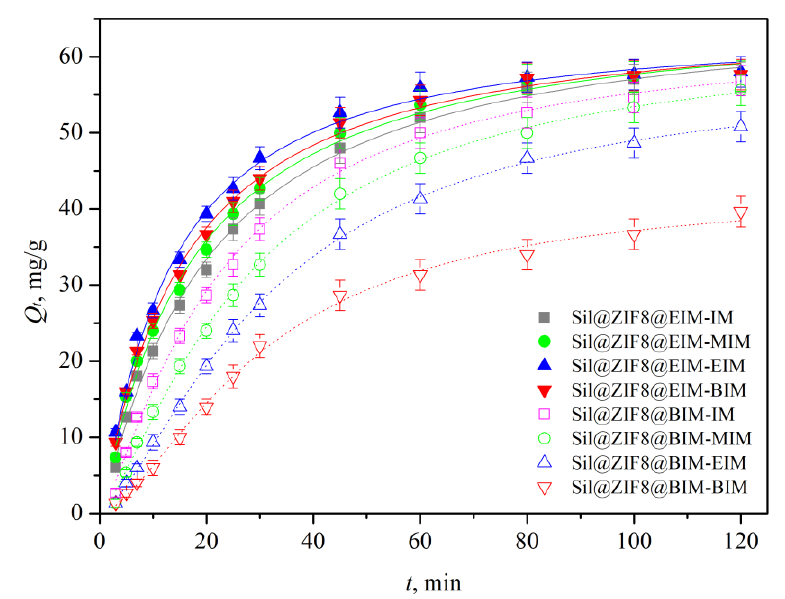
Figure 6. The relationships between adsorption time and adsorption amount ( Q t ) of (+)-catechin on